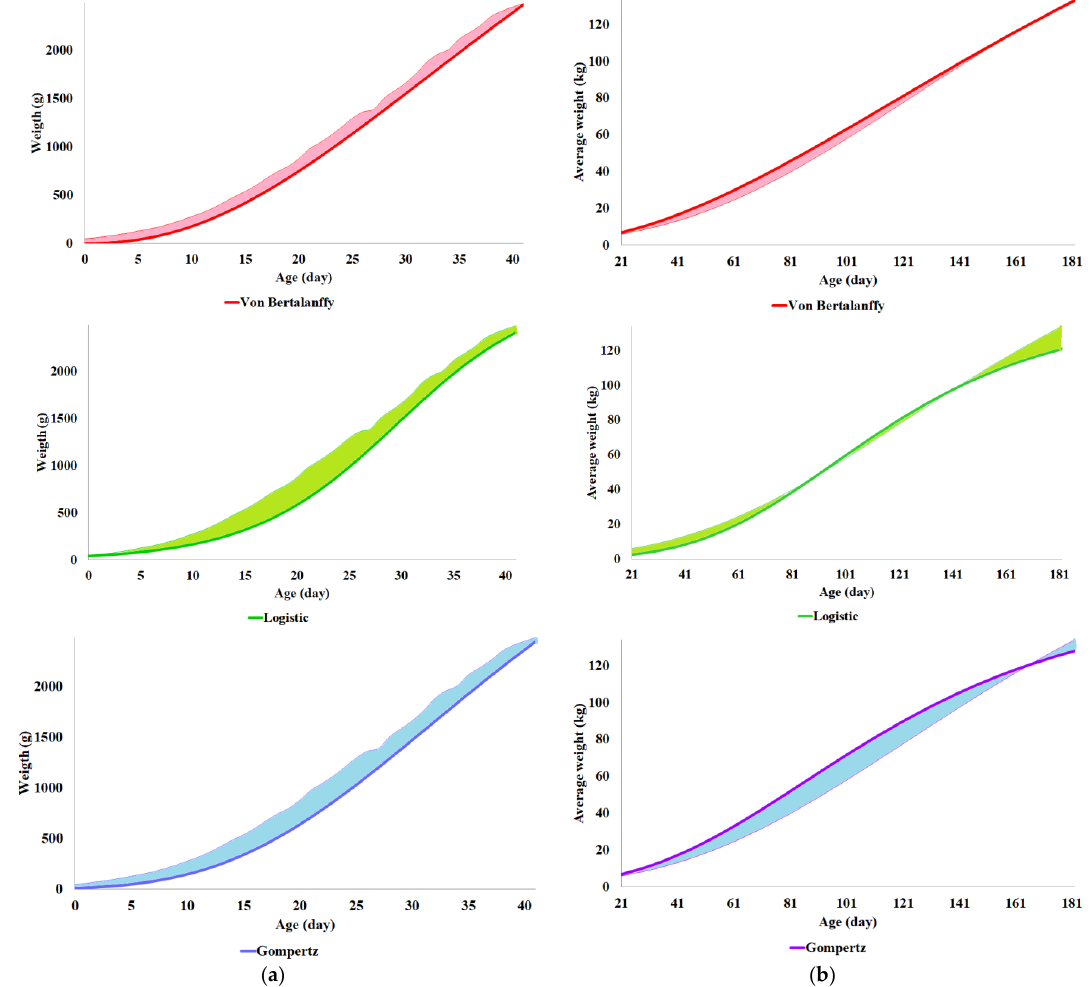
Figure 5. Simulated curves of the models with errors between the database curves for broilers ( a ) and pigs ( b ).